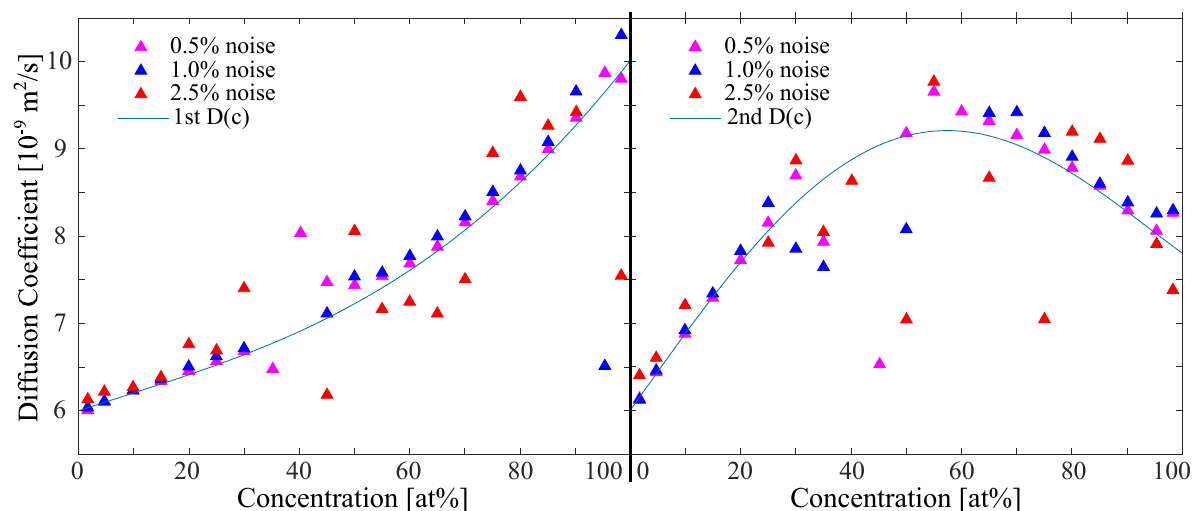
Figure 4. Effect of noise on the Numerical Fick’s Law Approach. Error bars exceed the chosen scale of the graph. They have not been plotted in favor of a clearer layout. The inaccuracy due to the fluctuations in the results of the algorithm is around 5–40%, increasing with noise. The error is also larger for center concentrations around 50 at%. Algorithm coefficients are chosen to be ∆ x = 25 px and ∆ t = 25 s.